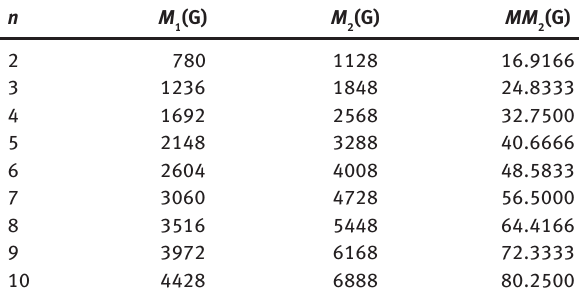
(G), M (G), and MM 1 2